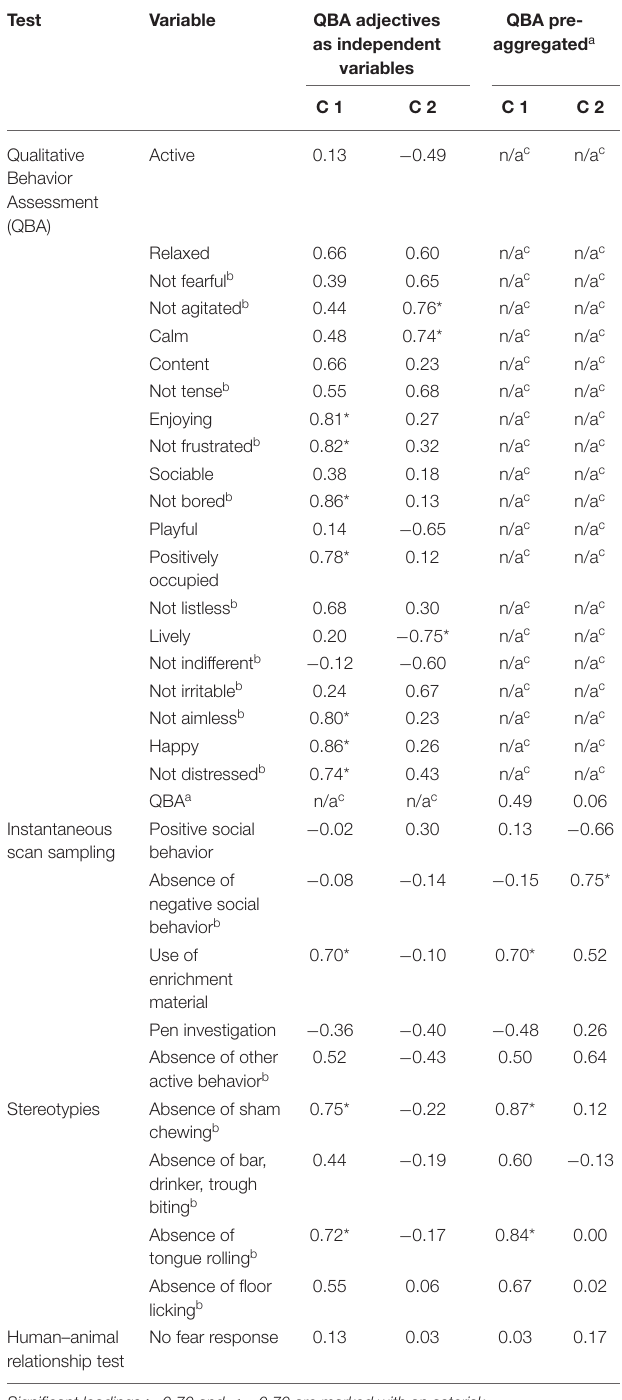
TABLE 3 | Loadings on detected components 1 and 2 (C1, C2) of the variables of the behavioral indicators in the rotated factor pattern of the PCA on sows’